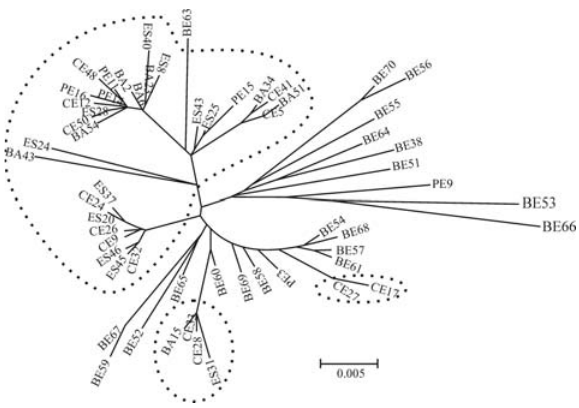
Figure 7 - mtDNA control-region haplotype neighbor-joining tree (Ki- mura 2-parameter distance). Dotted line surrounds haplotype clusters from the southwestern